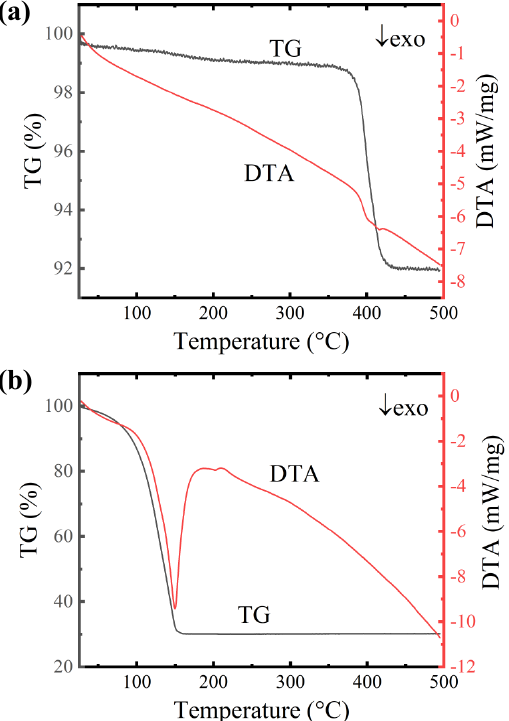
Figure 2. Thermogravimetric–differential thermal analysis (TG/DTA) analysis results of ( a ) the Ag 2 O powder and ( b ) the Ag 2 O paste with a heating rate of 10 °C/min in flowing N 2 gas.